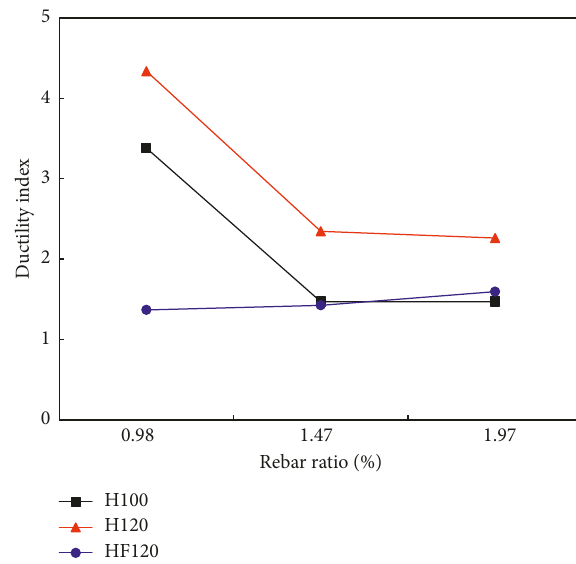
Figure 11: Ductility index of the HSC and HSFRC